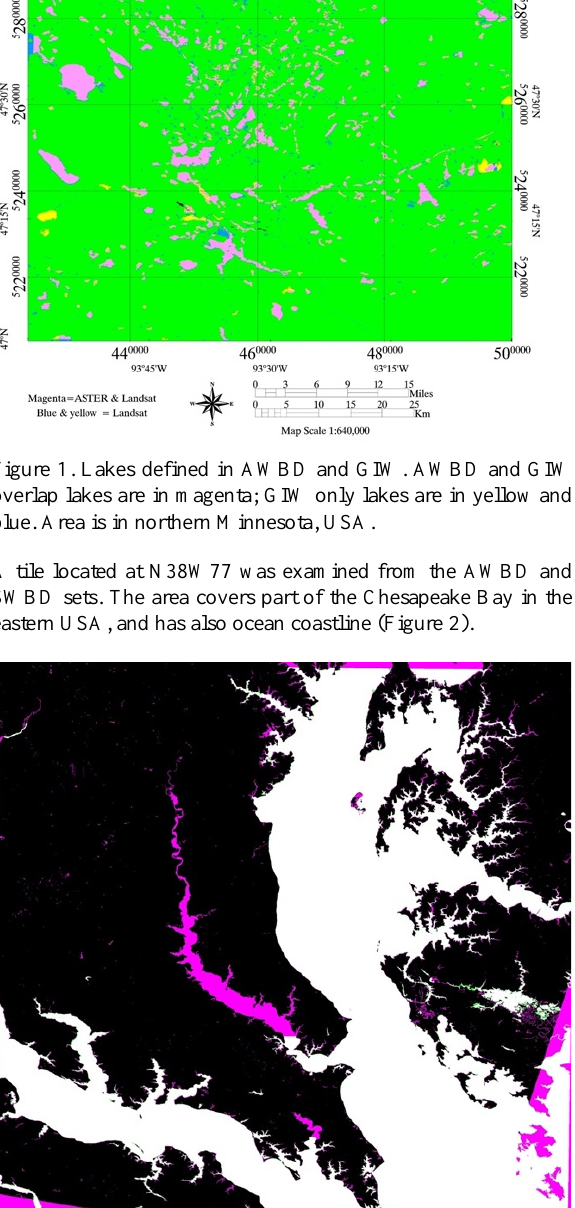
are coincidentally identified on both data sets. Note one large tributary that is not found in the AWBD data set. A few small tributaries are missed on the SWBD.